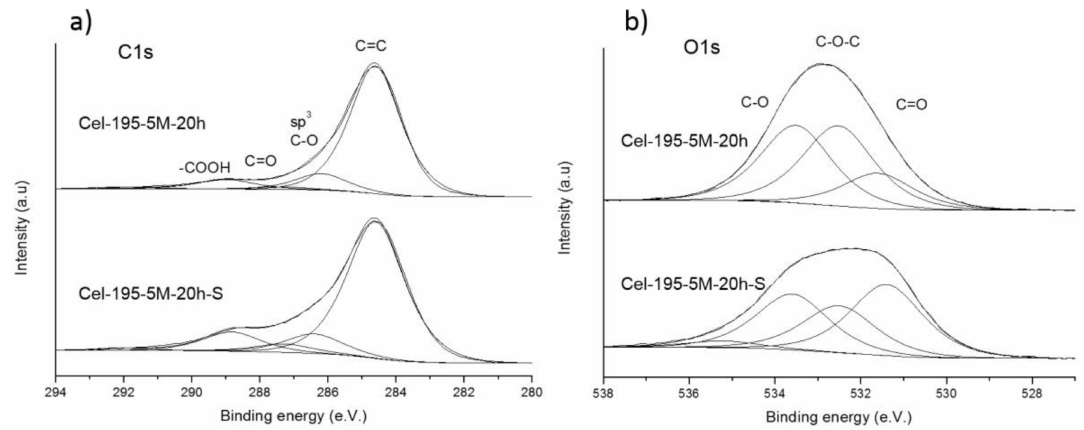
Figure 3. XPS spectra of Cel-195-5 M-20 h and Cel-195-5 M-20 h-S (samples 5 and 5-S, respectively): ( a ) C1s; ( b )